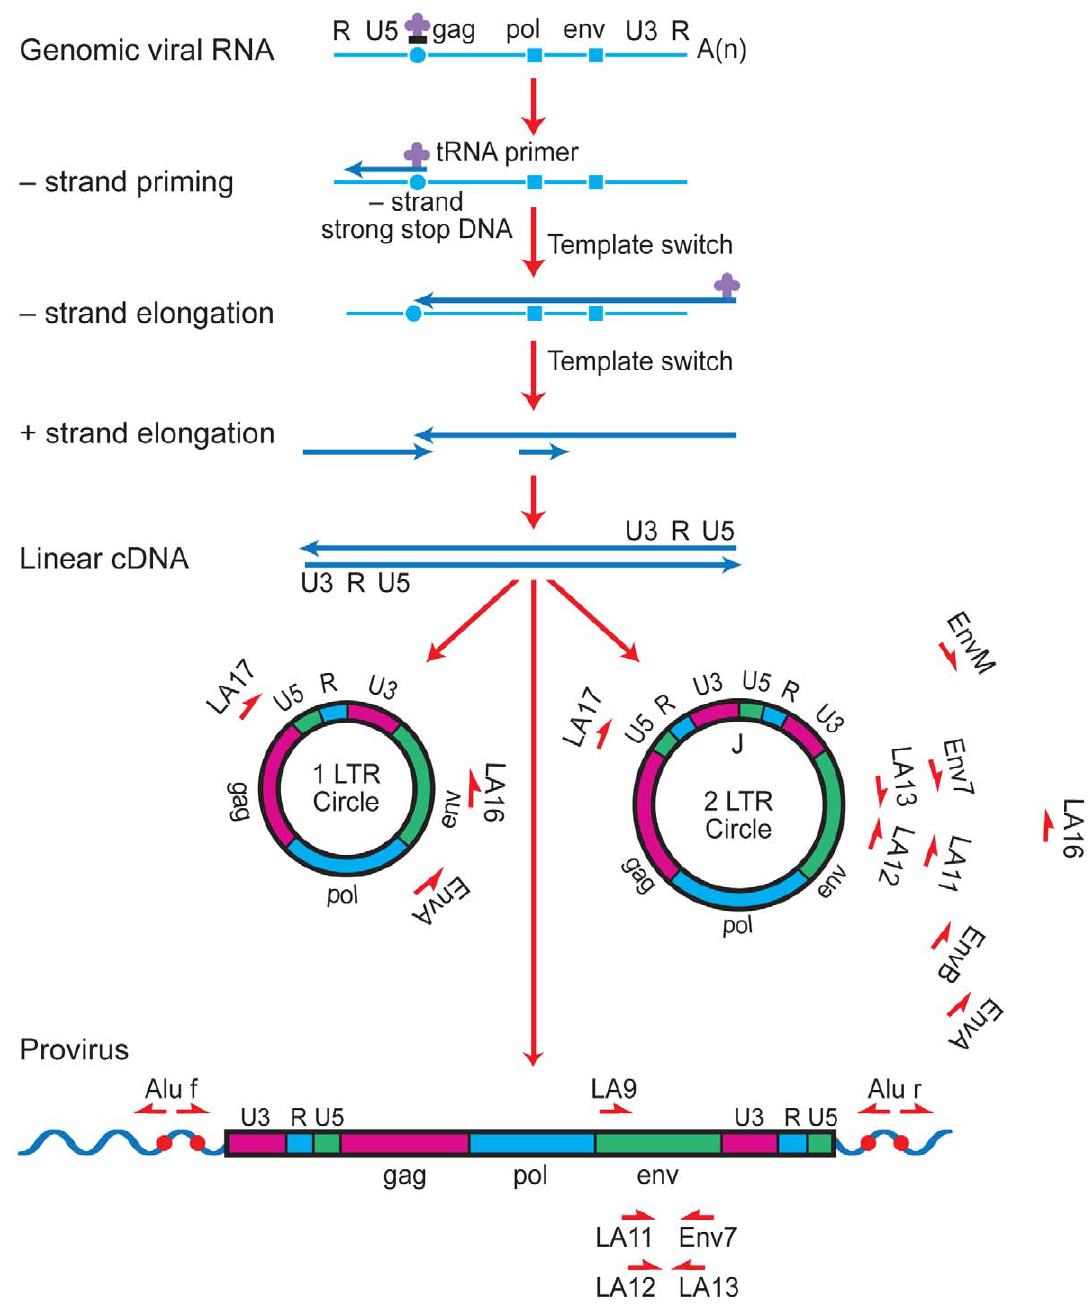
Figure 2. Strategy for long-range PCR amplification of episomal or proviral HIV-1 envelope sequences. Major cDNA intermediates in reverse transcription are denoted. Thin blue line, viral RNA; thick blue line, cDNA. Primer-binding sites for initiation of minus-strand cDNA synthesis and polypurine tracks for plus- or minus-strand synthesis are indicated by open circles and squares, respectively. Relative positions and orientations of first and second round PCR primers specific for the different forms of HIV-1 are listed.